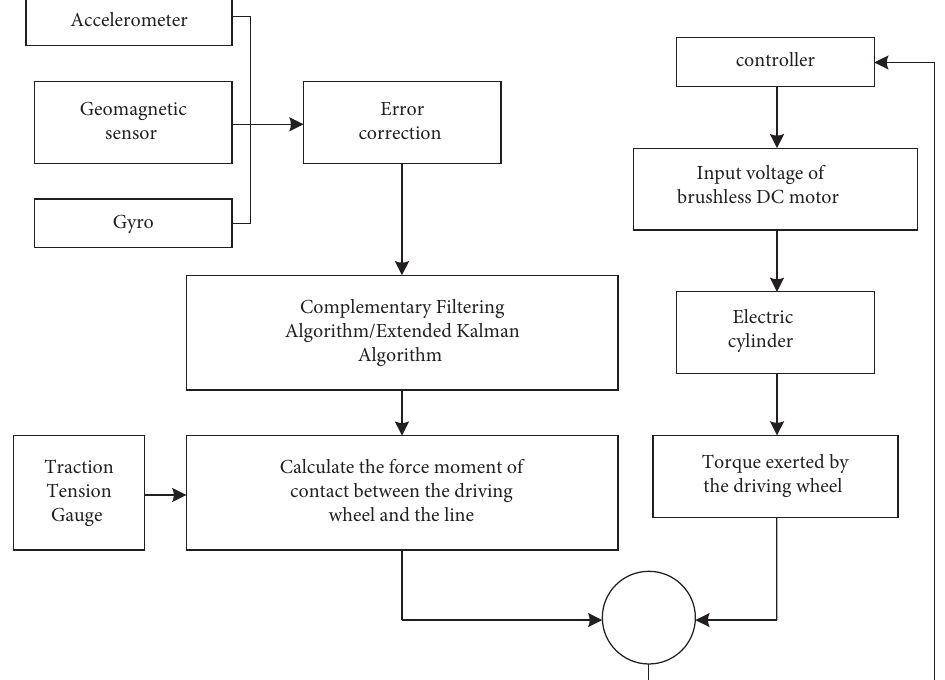
Figure 3: The design scheme of the lifting force control system.